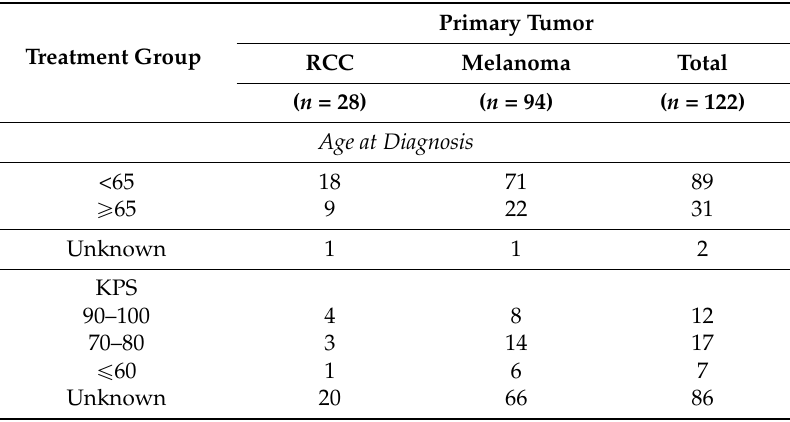
Table 1. Patient population baseline